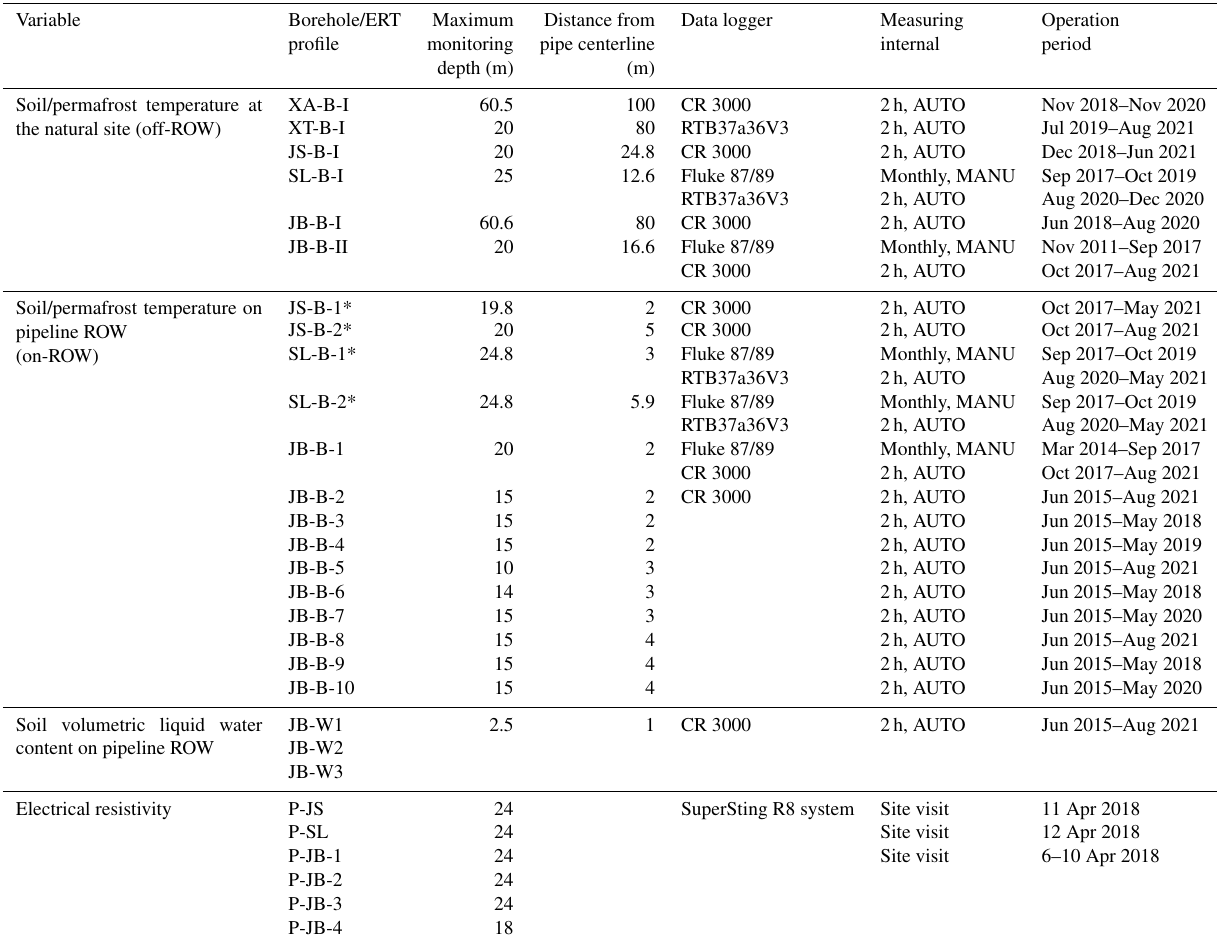
Table 3. Summary of monitoring information of ground temperature boreholes, water content monitoring pits, and electrical resistivity tomography (ERT) profiles along the China–Russia crude oil pipelines (CRCOPs) in Northeast China.